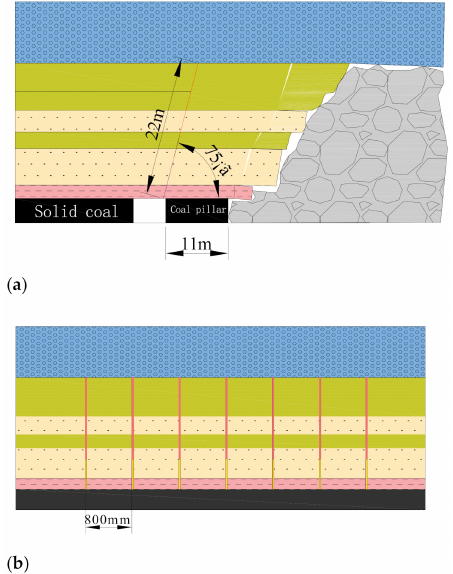
Figure 12. Drilling construction layout. ( a ) Site drilling construction plan. ( b ) Top view of site drilling construction layout.